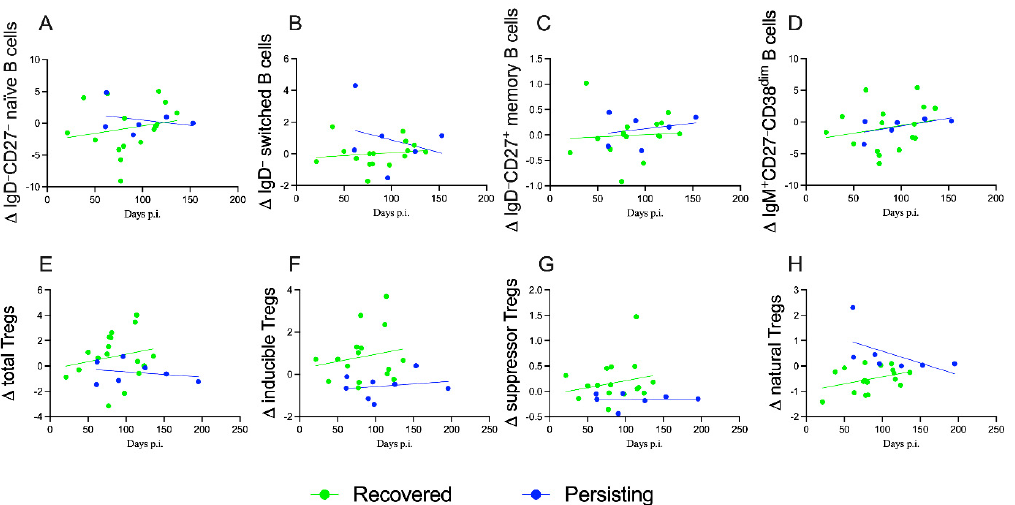
Figure 5. Modulation of T and B cells subsets during follow up of CoV2- infected children. Each graph shows the deltas of each variable during time (indicated as days post infection/diagnosis); symbols represent the different patients and are displayed with interpolation lines and confidence bands. The panels compare CoV2 -infected children who recovered (green circles and lines) with the ones with persistent symptoms (blue circles and lines). ( A – D ) display B cells subsets: naïve (F = 0.5453. DFn = 1, DFd = 18 and p = 0.4698), switched (F = 1.150. DFn = 1, DFd = 18 and p = 0.2977), memory (F = 0.04023. DFn = 1, DFd = 18 and p = 0.8433) and pre-transitional (F = 0.000019. DFn = 1, DFd = 18 and p = 0.9965) B lymphocytes, respectively. ( E – H ) show regulatory T cell subpopulations: total (F = 0.6585. DFn = 1, DFd = 20 and p = 0.4266), inducible (F = 0.1222. DFn = 1, DFd = 20 and p = 0.7303), suppressor (F = 0.3908. DFn = 1, DFd = 20 and p = 0.5389) and natural (F = 5.761. DFn = 1, DFd = 20 and p = 0.0262) Tregs, respectively. Simple linear regression revealed significant differences of the slopes only for natural Tregs ( H ).